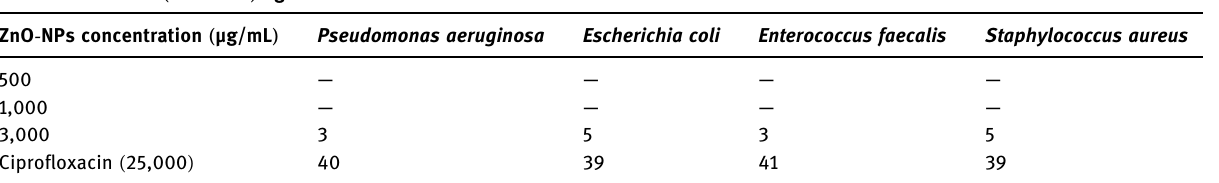
Table 1: Well di ff usion method for analysis of the antibacterial activity of ZnO - NPs against four bacteria strains and cipro fl oxacin is used as a positive control Zone of inhibition ( mm ± SD ) against bacteria